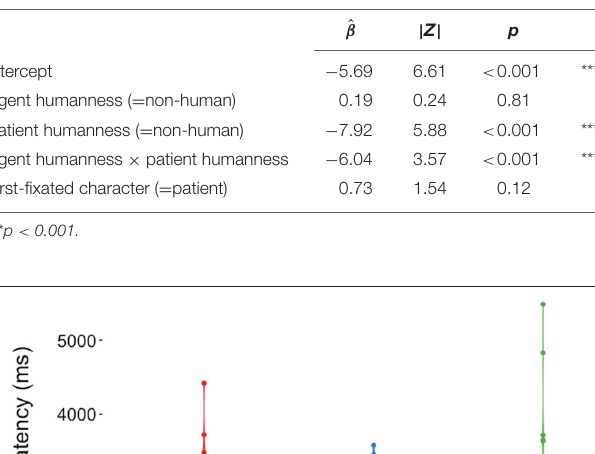
TABLE 2 | Results from binomial generalized linear mixed effects regression model predicting voice choice.